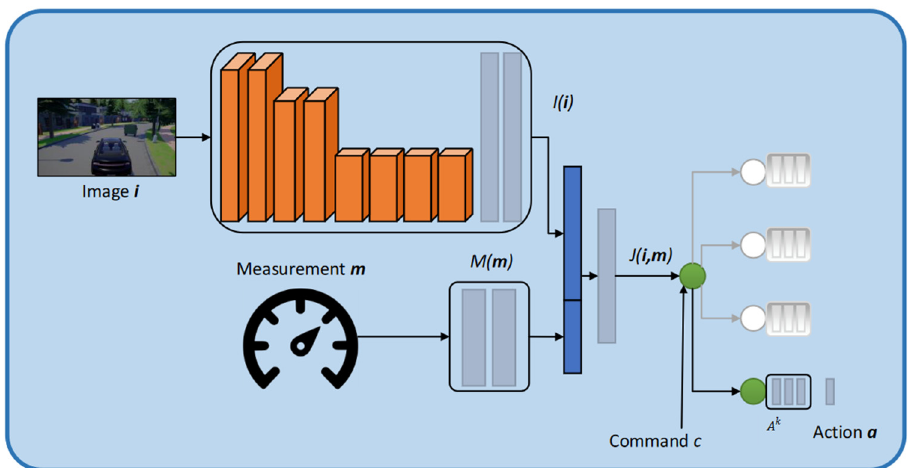
Figure 1. Fundamental conditional imitation learning (CIL) Architecture.